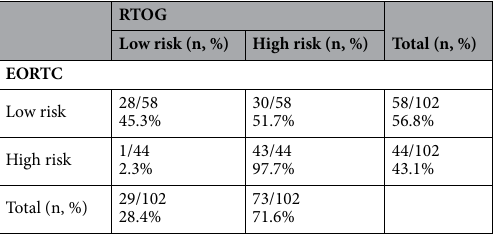
Table 3. Degree of consistency between EORTC and RTOG